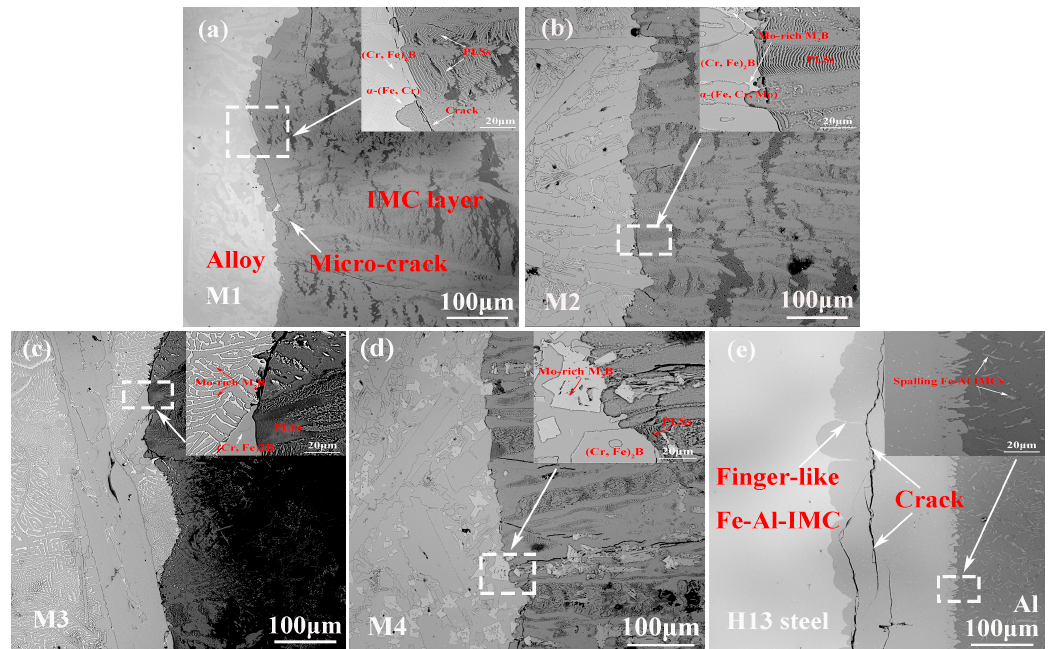
Figure 6. Cross-sectional BSE images of corrosion layers corroded by molten aluminum at 750 °C for 8 h: ( a ) M1; (b) M2; ( c ) M3; ( d ) M4; ( e ) H13. The top right corner images are the high magnification views of the images that are marked with rectangles.